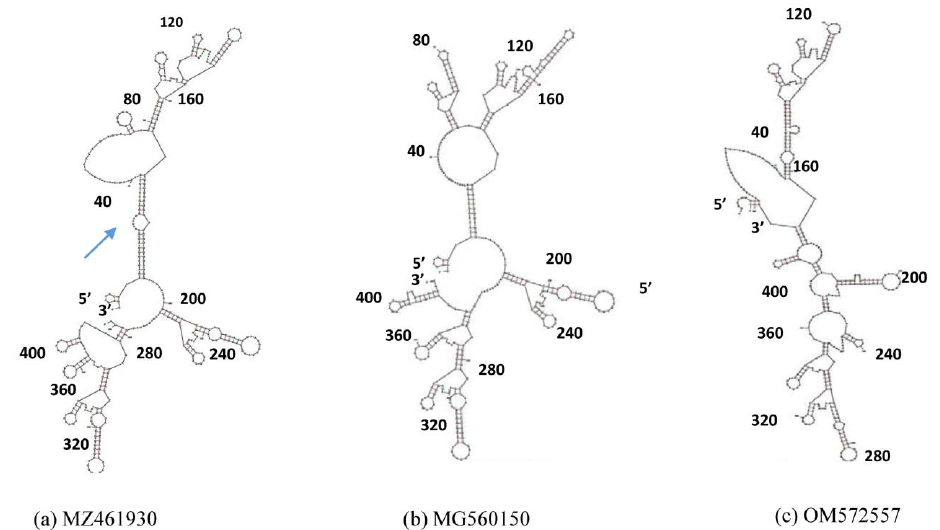
Figure 6. Predicted 3′ UTR RNA secondary structure developed using the UNAfold web server for the three strains with accession numbers ( a ) MZ461930 (full sequence), ( b ) MG560150 (∆ 8 nts), and ( c ) OM572557 (∆2 2 nts).